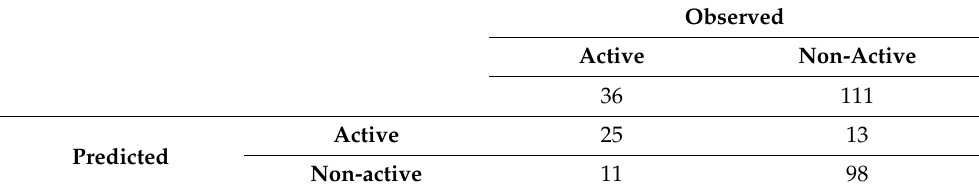
Figure 3. The effect of compounds 71 and 84 on the LPS-induced monocyte IL-6 production. MonoMac-6 cells were pretreated with the indicated concentrations of the test compounds or DMSO for 30 min, followed by an addition of 250 ng/mL LPS or buffer for 24 h. The production of IL-6 in the supernatants was evaluated by ELISA, as described. The data are presented as the mean ± S.D. of triplicate samples from one experiment that is representative of three independent experiments. Table 4. Misclassification matrices for the binary classification trees obtained for the NF- κ B inhibitory activity of the test